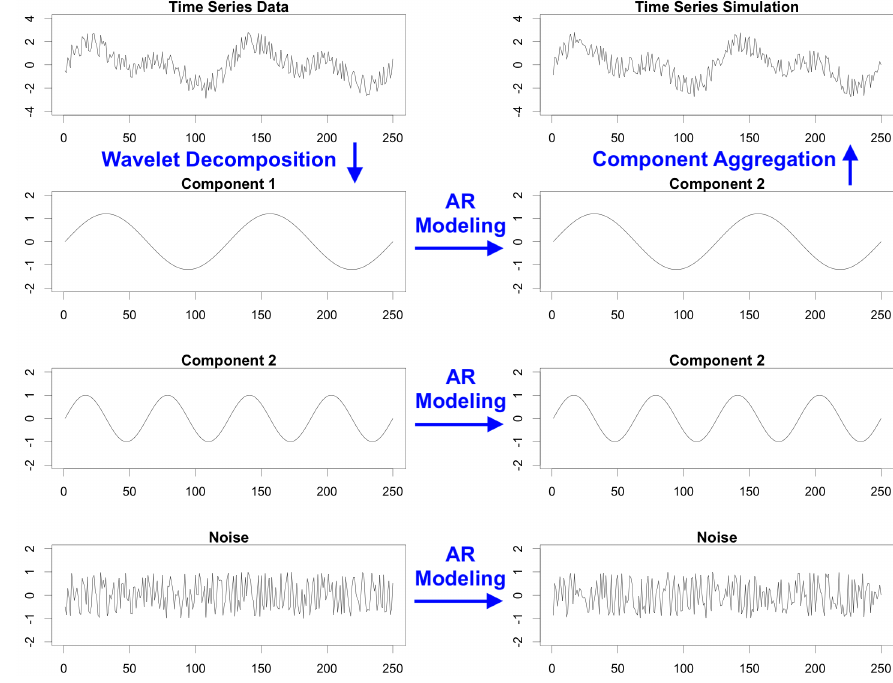
Figure 2. Example diagram of wavelet decomposition and aggregation using the enhanced WARM. Whereas the standard Fourier transform is localized in frequency, wavelets are localized in both frequency and